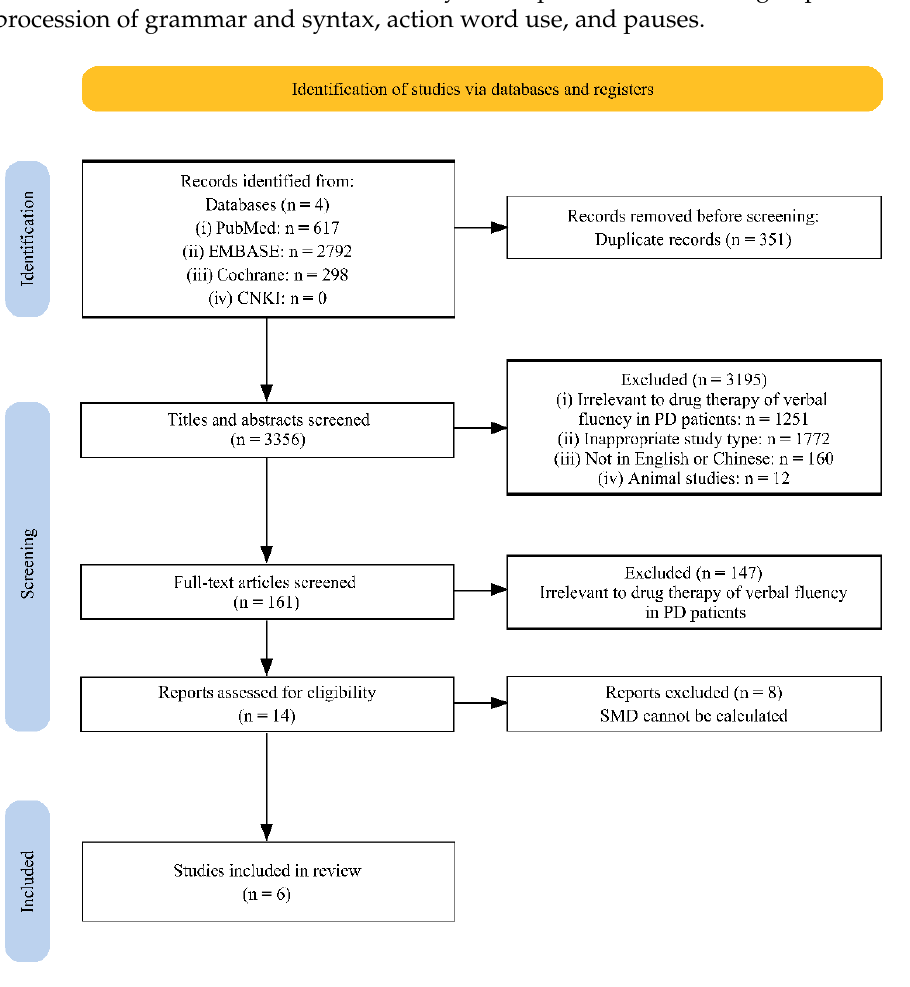
Figure 1. PRISMA flow-chart displaying study selection process. Diagram adapted from Reference [35].